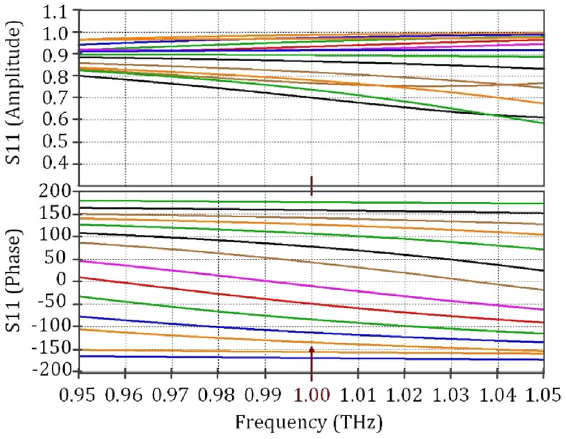
Figure 10. Amplitude and phase variations of the proposed unit-cell for different voltage biases and slot lengths.GeapheneFermi level is 0 to 0.2 eV, and the relaxation time is 1 ns.